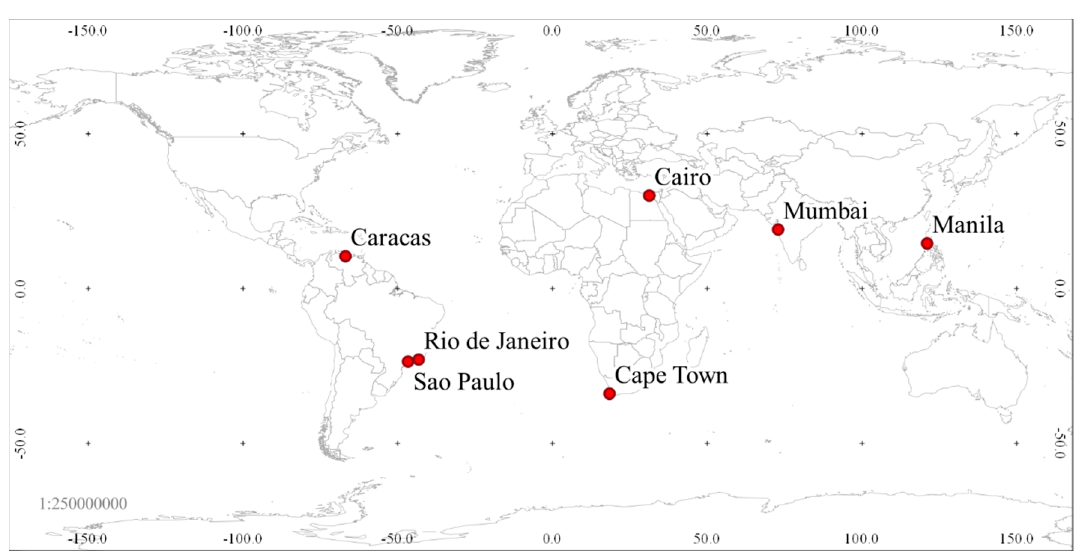
Table 2. Satellite data used for classification of morphological settlement